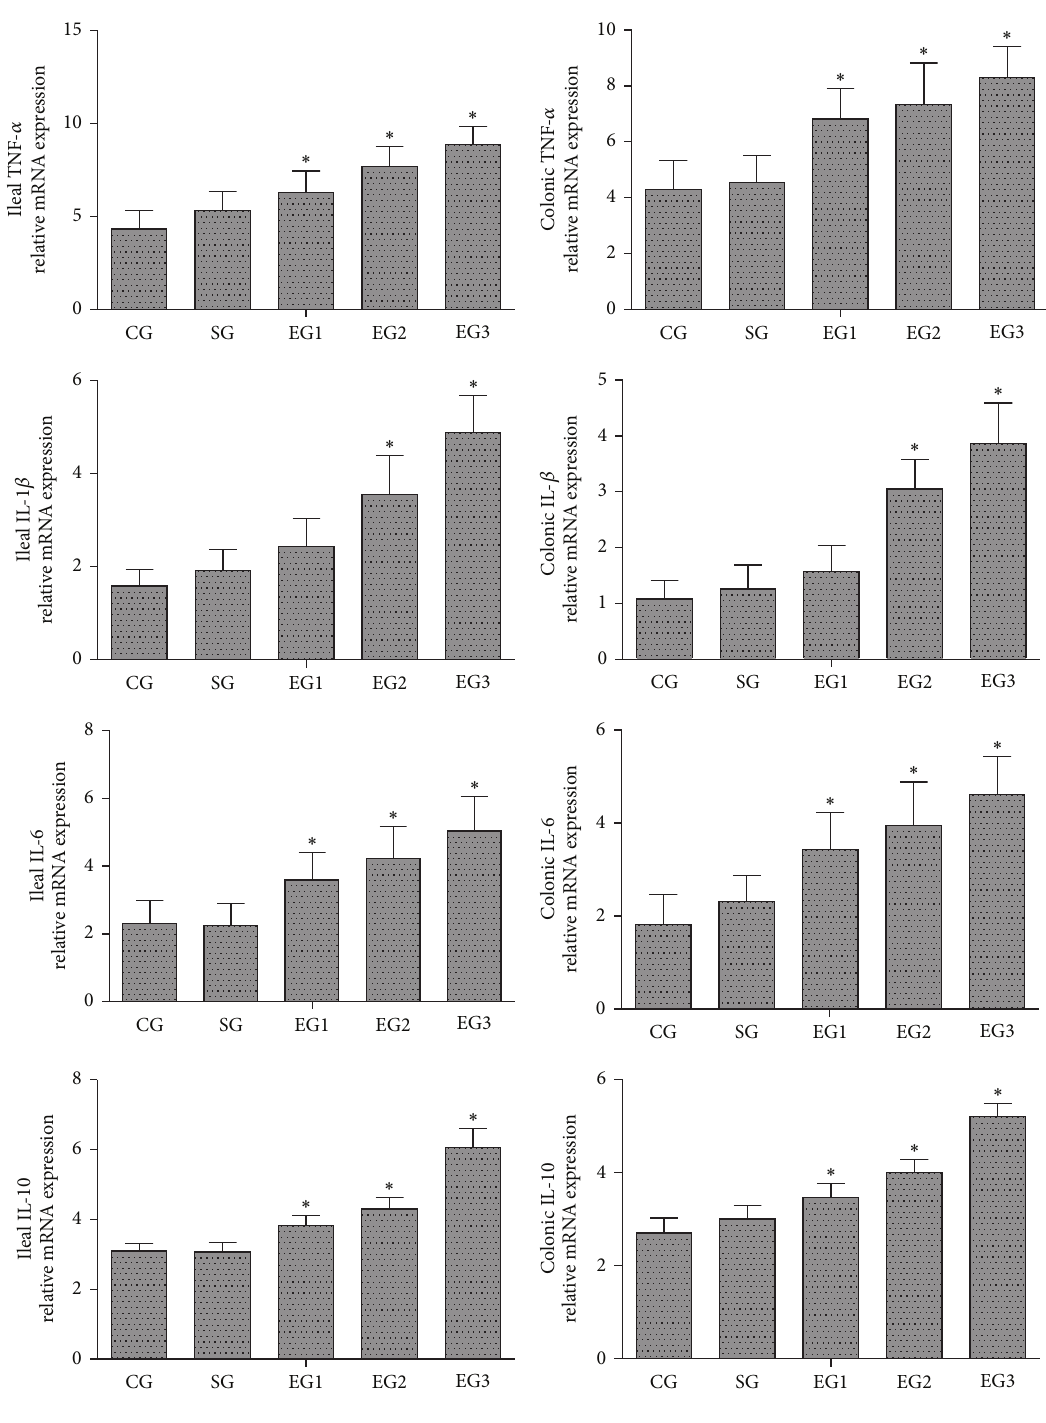
Figure 4: Relative mRNA expression of TNF- 𝛼 , IL-1 𝛽 , IL-6, and IL-10 in the tissues of ileum and colon. CG: control group; SG: sham group; EG1, EG2, and EG3: exposure groups with peritoneal air exposure for 1, 2, and 3 h, respectively. Data are expressed as mean ± SD, 𝑛 = 8 . ∗ 𝑃 < 0.05 , versus the CG group.